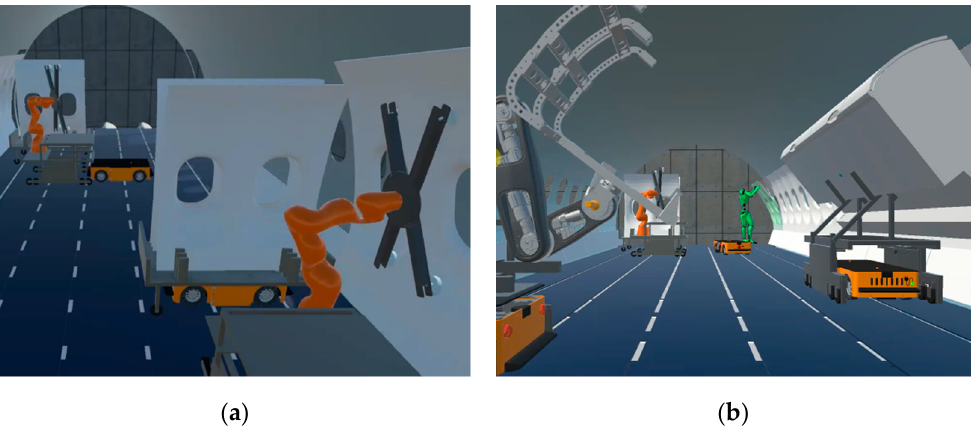
Figure 6. Aircraft final assembly line simulation. ( a ) Robot arms placing sidewall panels while automated guided vehicles (AGVs) move the part racks. ( b ) HRC of a human and a robot arm placing sidewall panels, AGVs moving the part racks, and a custom robot moving to the place where it should lift the hatrack.